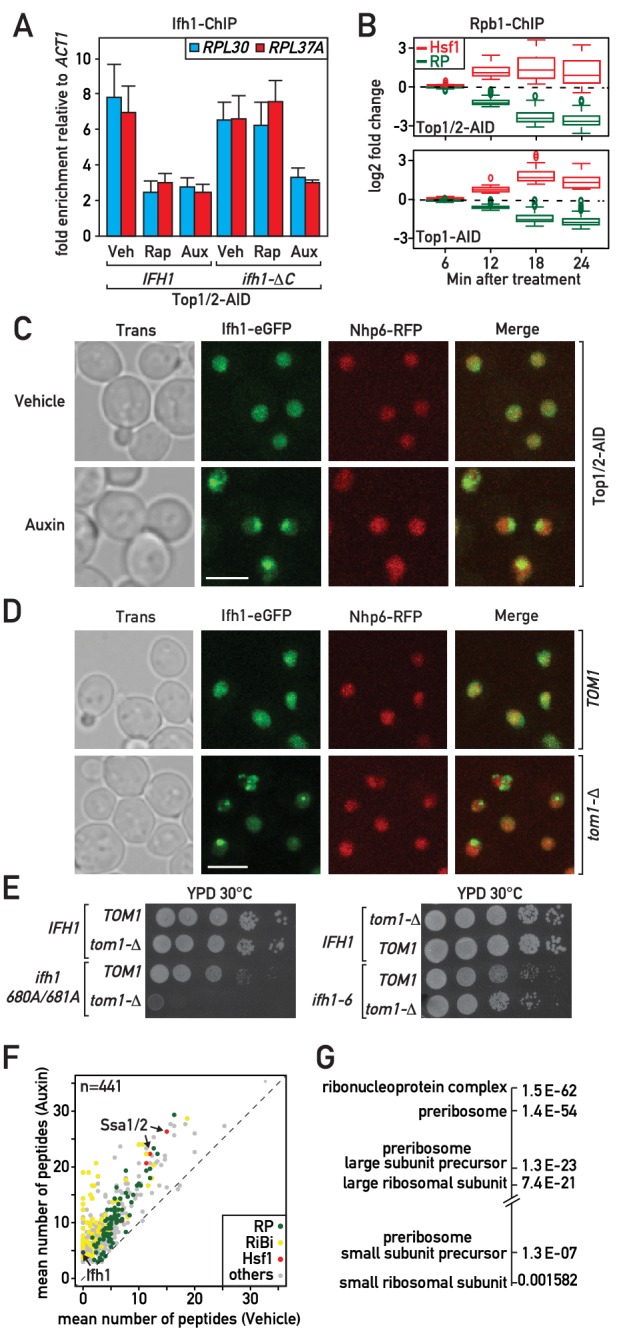
Evidence that Ifh1 is rapidly removed from RP gene promoters and sequestered in an insoluble nucleolar fraction pursuant to unassembled RP accumulation following RASTR initiation.(A) Ifh1 occupancy at the RPL30 and RPL37A promoters 20 min following vehicle, rapamycin or auxin treatment of Top1/2-AID strains expressing either WT Ifh1 (IFH1) or a C-terminal truncated allele (ifh1-∆C). Bar height indicates the average and error bars the range of N = 4 biological replicates. (B) Box plots showing the kinetics of RNAPII ChIP-seq changes at Hsf1 target and RP genes at the indicated time points (minutes) following auxin treatment in Top1/2-AID (top panel) or Top1-AID (bottom panel) strains. (C) A Top1/2-AID strain expressing Ifh1-eGFP and Nhp6-mCherry was grown exponentially and cell samples were used for fluorescence microscopy analysis after 20 min of auxin (Aux) or vehicle (Veh) treatment. (D) TOM1 (top panels) and tom1-Δ (bottom panels) strains expressing Ifh1-eGFP and Nhp6-mCherry were grown exponentially and cell samples were used for fluorescence or transmission microscopy analysis, as indicated. (E) Tenfold serial dilutions of IFH1, ifh1-AA (ifh1 680A/681A) or ifh1-6 cells transformed in either TOM1 or tom1-Δ backgrounds (as indicated) were grown in YPD medium for 44 hr at 30°C before being photographed. (F) Scatter plot comparing average number of peptides purified in an insoluble fraction from Top1/2-AID cells treated for 20 min with either auxin (y-axis, Auxin) or vehicle (x-axis, Vehicle). Each dot represents a protein, color-coded according to functional group as above (green: RP, red: Hsf1 target gene product, yellow: RiBi protein, gray: others), with some specific proteins indicated by arrows. (G) Gene Ontology and p-values of protein groups that are the most enriched in the insoluble fraction following Top1/2-AID depletion (Δ > 3 peptides in insoluble fraction after topoisomerase depletion compared to vehicle in all experiments, n = 3 biological replicates).